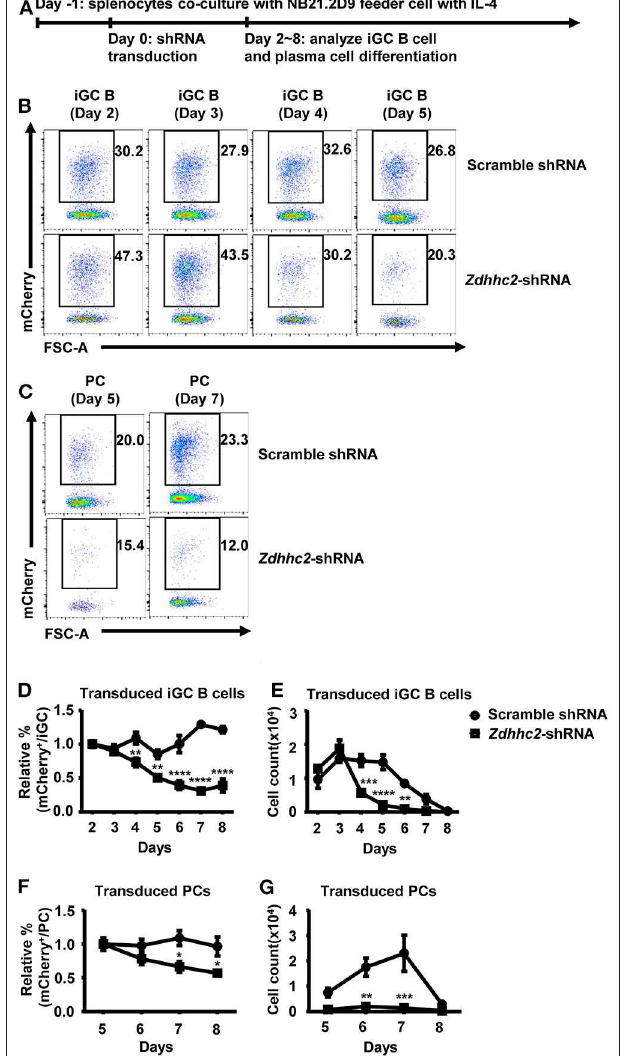
FIGURE 4 | Reduced in vitro differentiation of Zdhhc2 -shRNA transduced B cells into germinal center (GC) B cells and plasma cells. (A) The in vitro model for analyzing iGC B cell and plasma cell differentiation. The wild-type (WT) splenic cells were co-cultured with irradiated NB-21.2D9 feeder cells (expressing CD40L, BAFF, and IL21) in the presence of 2ng/ml of IL-4 on day − 1, transduced with scramble shRNA or Zdhhc2 -shRNA-2 retroviral vectors (expressing mCherry) on day 0, and analyzed for iGC B cell and plasma cell differentiation from day 2 to day 8. (B,C) Representative flow cytometry profiles showing the percentages of scramble shRNA or Zdhhc2 -shRNA transduced cells (mCherry + ) among iGC B cells (B220 + Fas + GL7 + ) as cultured in (A) on days 2–5 (B) and plasma cells (B220 + CD138 + IgG1 + or PC) on day 5 and day 7 (C) . (D–G) Representative graphs showing the relative percentage (D,F) or the absolute number (E,G) of scramble shRNA or Zdhhc2 -shRNA transduced cells among iGC B cells (normalized to the values on day 2) (D,E) or plasma cells (normalized to the values on day 5) (F,G) at the indicated time points (days 2–8 for iGC B cells, days 5–8 for PC) in the cultures described as in (A) . The bars represent mean ± SEM. * p ≤ 0.05, ** p ≤ 0.01, *** p ≤ 0.001, **** p ≤ 0.0001, two-way ANOVA with Sidak’s multiple-comparisons test. A representative of two independent experiments is shown.